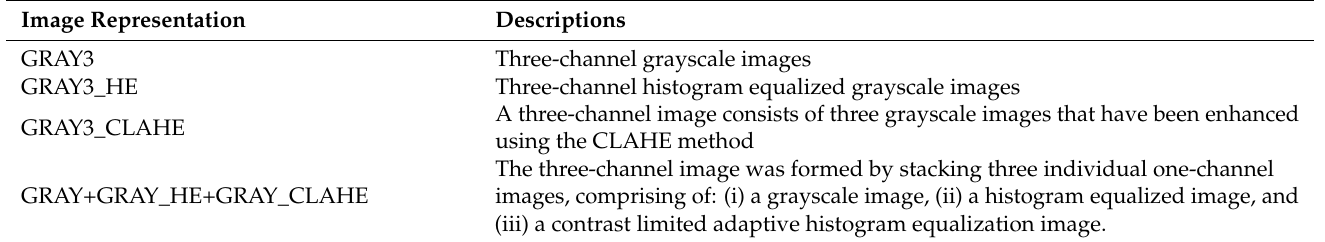
Table 2. Description of the image representations.